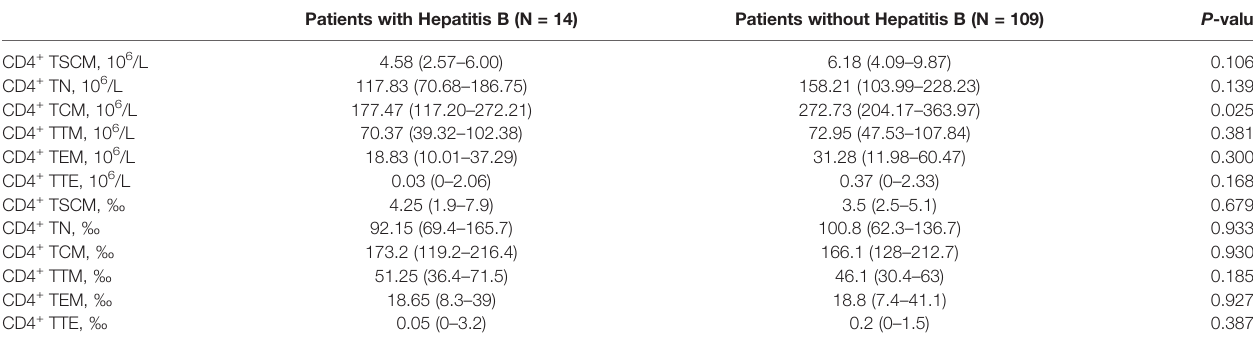
TABLE 4 | Differences in the frequency and absolute value of CD4+ lymphocyte subsets in patients with or without Hepatitis B. Patients with Hepatitis B (N = 14) Patients without Hepatitis B (N =